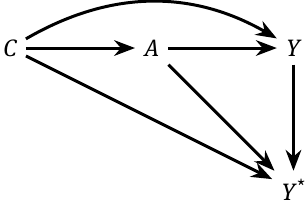
Figure 1: Differential misclassification in the measurement of outcome Y *